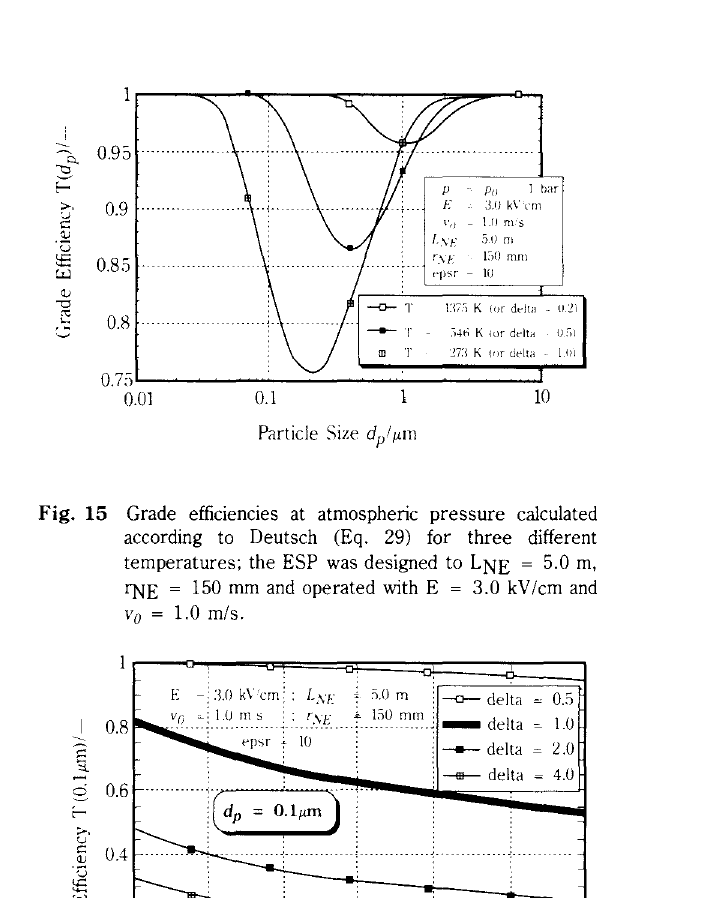
Fig. 16 Efficiencies according to Deutsch (Eq. 29) for a 0.1 p.m particle as a function of temperature; different lines correspond to different relative gas densities. ESP design and operation conditions as before.